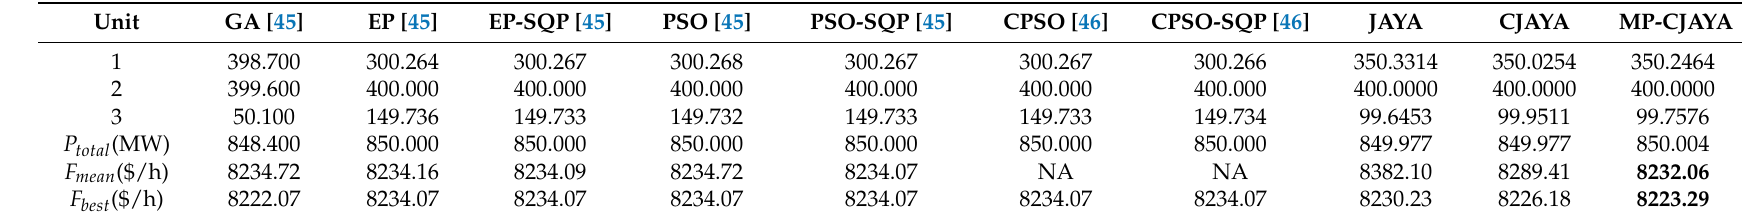
Table 2. Best outputs for 3-units system ( P D = 850